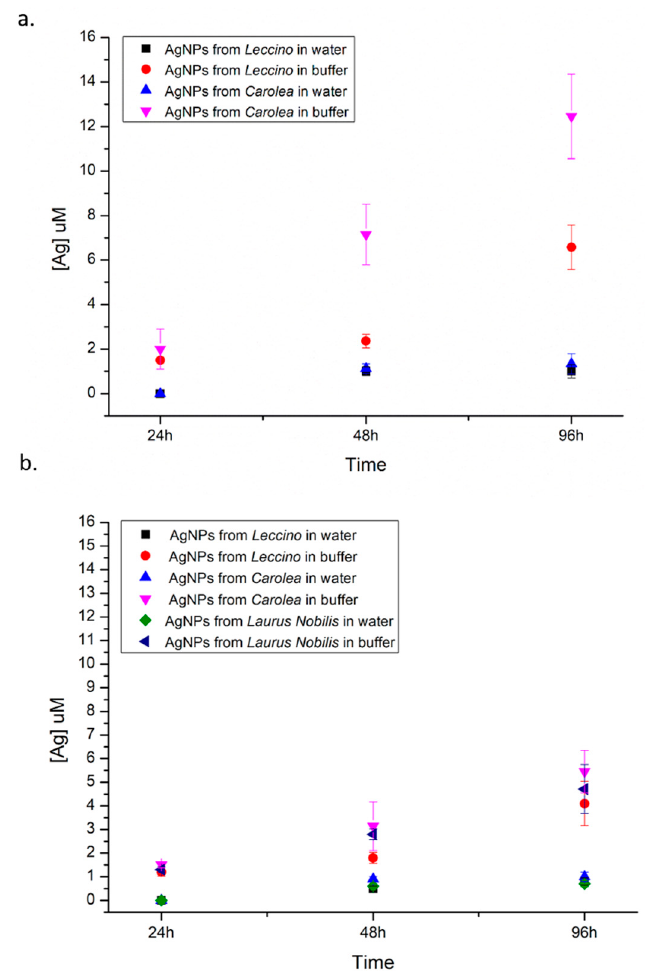
Figure 12. E ff ects of time and pH on silver ions release from AgNPs (50 µ g / mL) derived from Leccino and Carolea obtained at pH 7 ( a ) and AgNPs from Leccino , Carolea and Laurus Nobilis at pH 8 ( b ). NPs degradation was evaluated both in bu ff er (pH 4.5) and in water (pH 7) up to 96 h. NPs degradation in neutral conditions was analysed also in culture medium, finding the same behaviour observed in water (data not